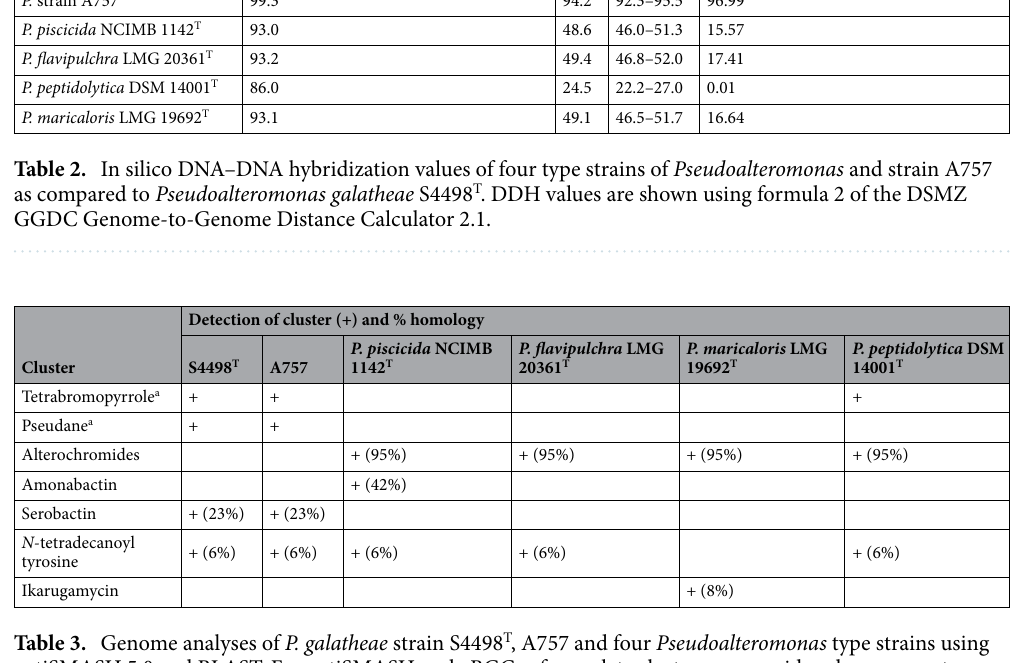
Table 3. Genome analyses of P. galatheae strain S4498 T , A757 and four Pseudoalteromonas type strains using antiSMASH 5.0 and BLAST. For antiSMASH, only BGCs of complete clusters are considered. + represents presence of the cluster. a Detected using BLAST, not identified in antiSMASH.